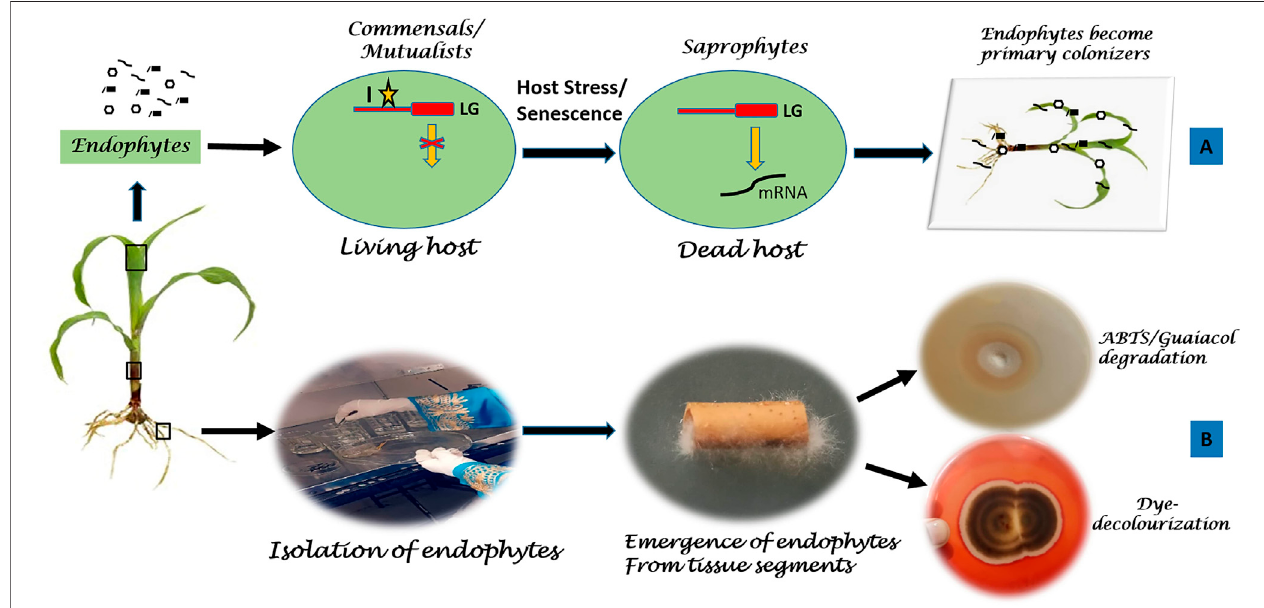
FIGURE3| Endophytesaslignindecomposers. (A) Schematicoverviewofnaturalendophyticdeligni fi cation. (B) Pictorialviewof invitro investigationofendophytic deligni fi cation. Where I, Inhibitor; LG, ligninase gene; ABTS, [2, 2 ′ -azino-bis (3-ethylbenzothiazoline-6-sulfonic acid].